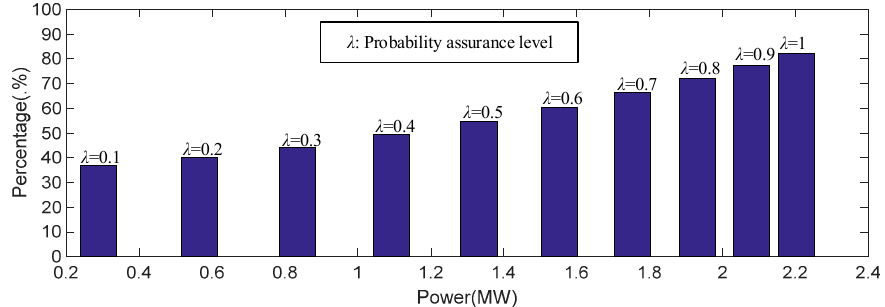
Figure 6. The tendency of the decreased percentage of the fluctuation degree of the pulsating power ( ∆ P flu ) to vary along with the optimized energy storage power ( P st ).